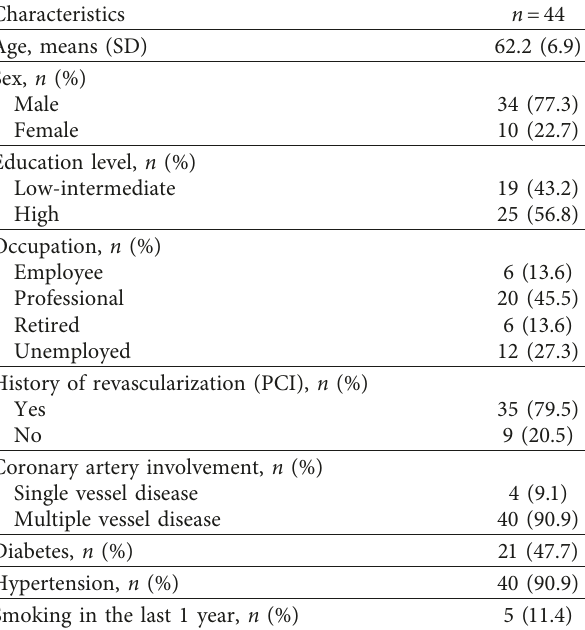
Table 1: Subject characteristics. Characteristics